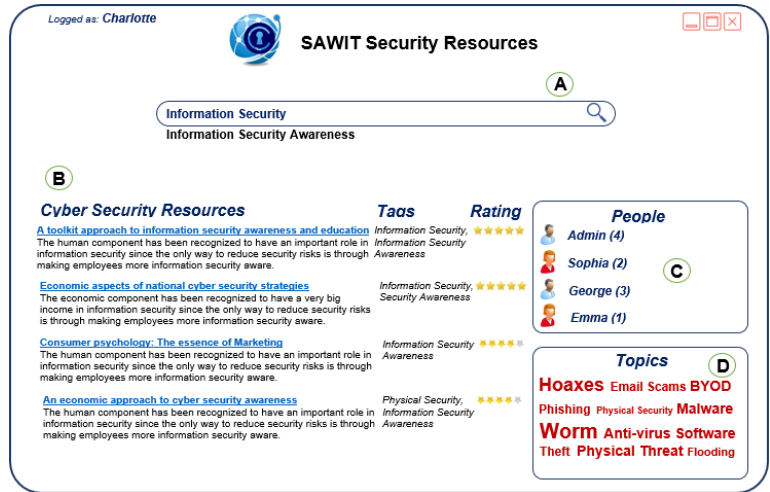
Figure 3. SAWIT Security Resources dialog ( A ) Semantic Search Engine ( B ) Cyber Security Resources ( C ) Search by People ( D ) Search by Topics.